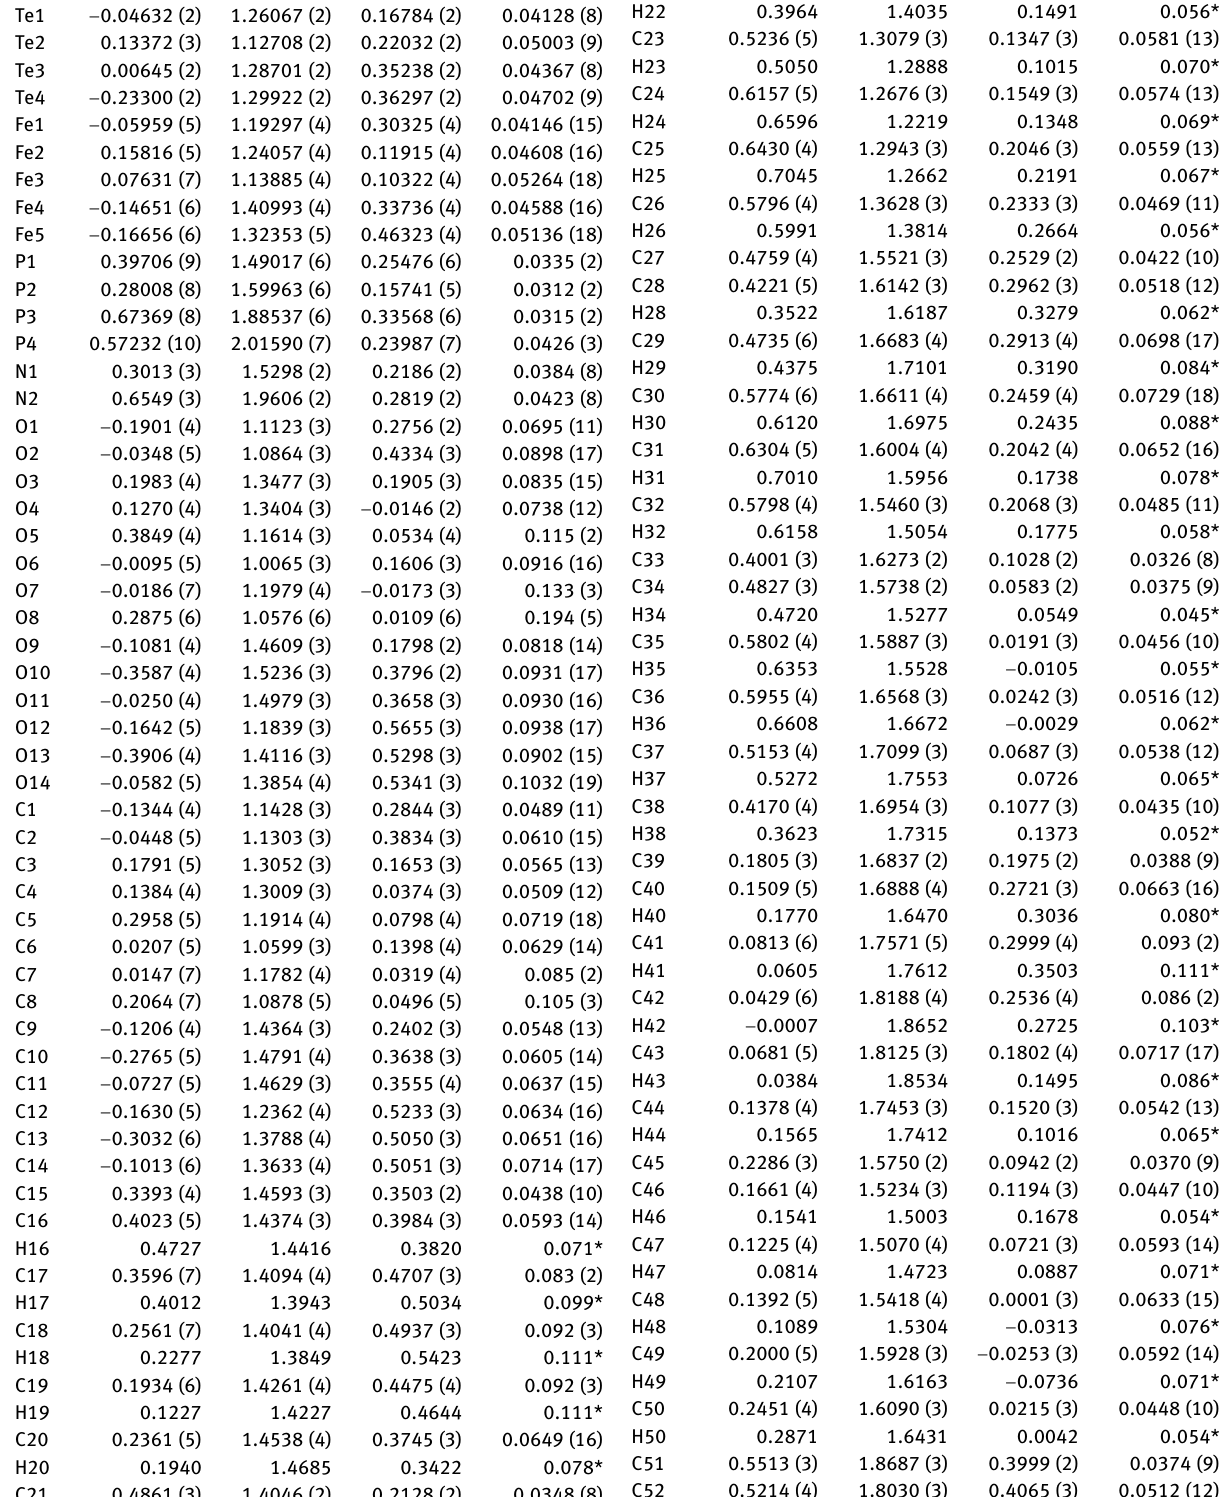
Table  : Fractional atomic coordinates and isotropic or equivalent isotropic displacement parameters (Å 